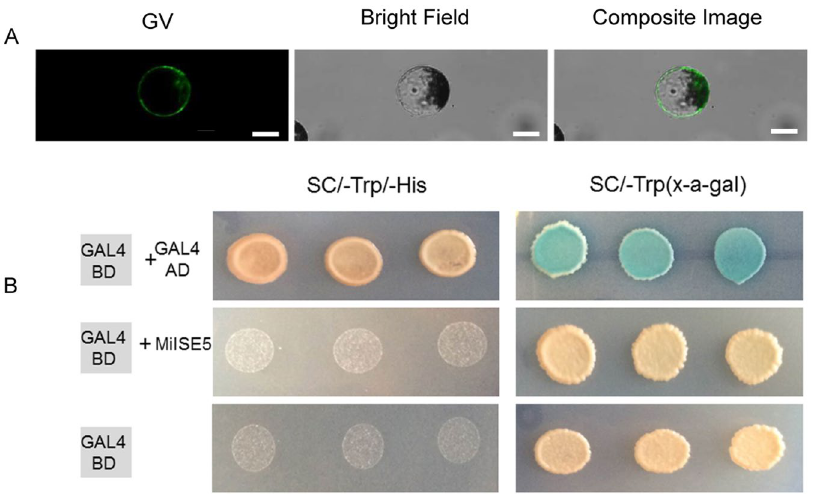
Figure 7. Subcellular localization of transiently expressed MiISE5 Δ sp :GFP in Arabidopsis protoplasts and testing of transcriptional activation ability of MiISE5 in yeast. ( A ) MiISE5 Δ sp was localized to the cytoplasm. ( B ) The MiISE5 was fused with GAL4BD and expressed in yeast cells. GAL4BD and GAL4BD-GAL4AD were used as negative and positive controls, respectively. The blue yeast colonies on synthetic medium without tryptophan (SC/-Trp) with the chromogenic substrate 5-bromo-4-chloro-3-indolyl- α omogalactopyranoside (X- α -Gal) indicate the expression of MEL-1 gene. The successful growth of yeast colonies on synthetic medium without tryptophan and histidine (SC/-Trp/-His) indicate the expression of the HIS3 reporter gene. Scale bar = 50 μ